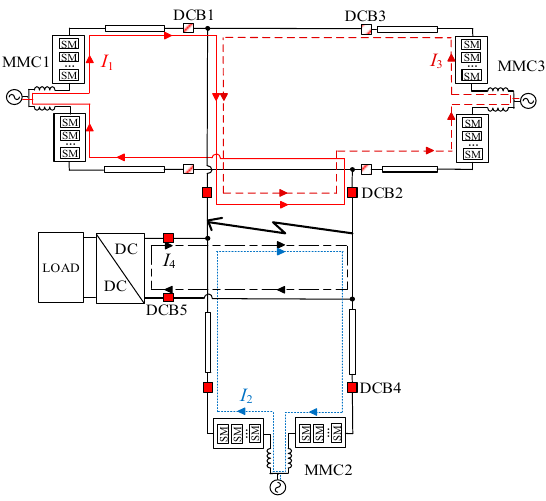
Figure 4. Equivalent circuit of pole-to-pole fault